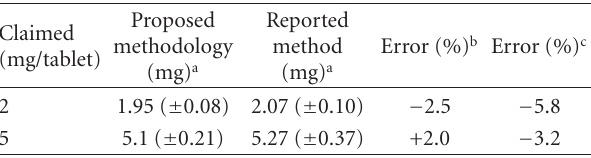
Table 2: Determination of terazosin in tablets by the proposed methodology and by a reported voltammetric method